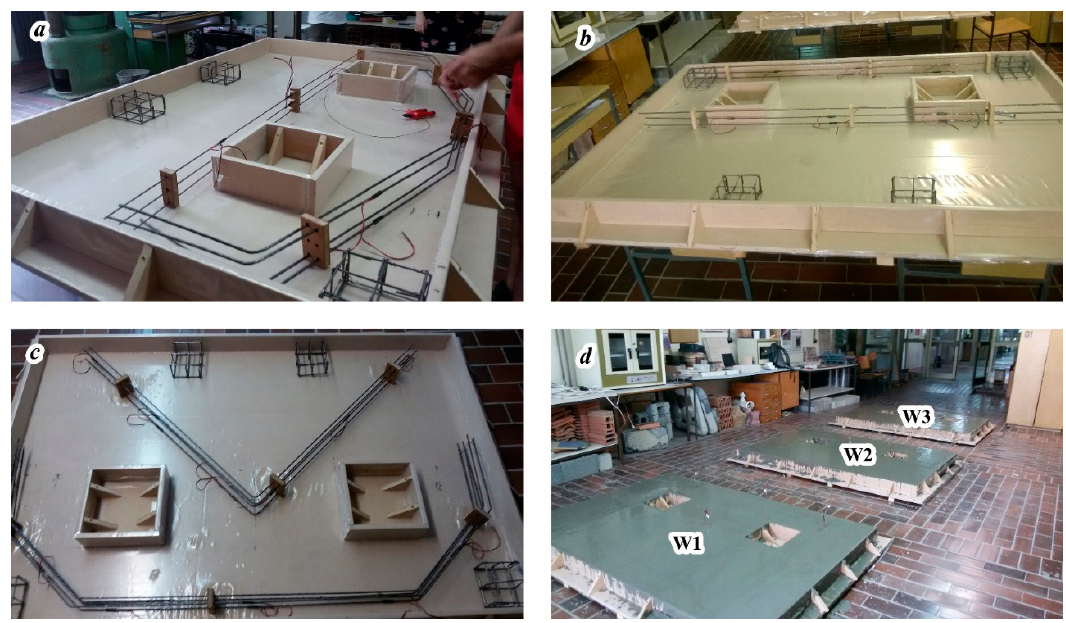
Figure 9. ( a ) Formwork with reinforcement: ( a ) W1, ( b ) W2, ( c ) W3, and ( d ) concreted reinforced concrete members.